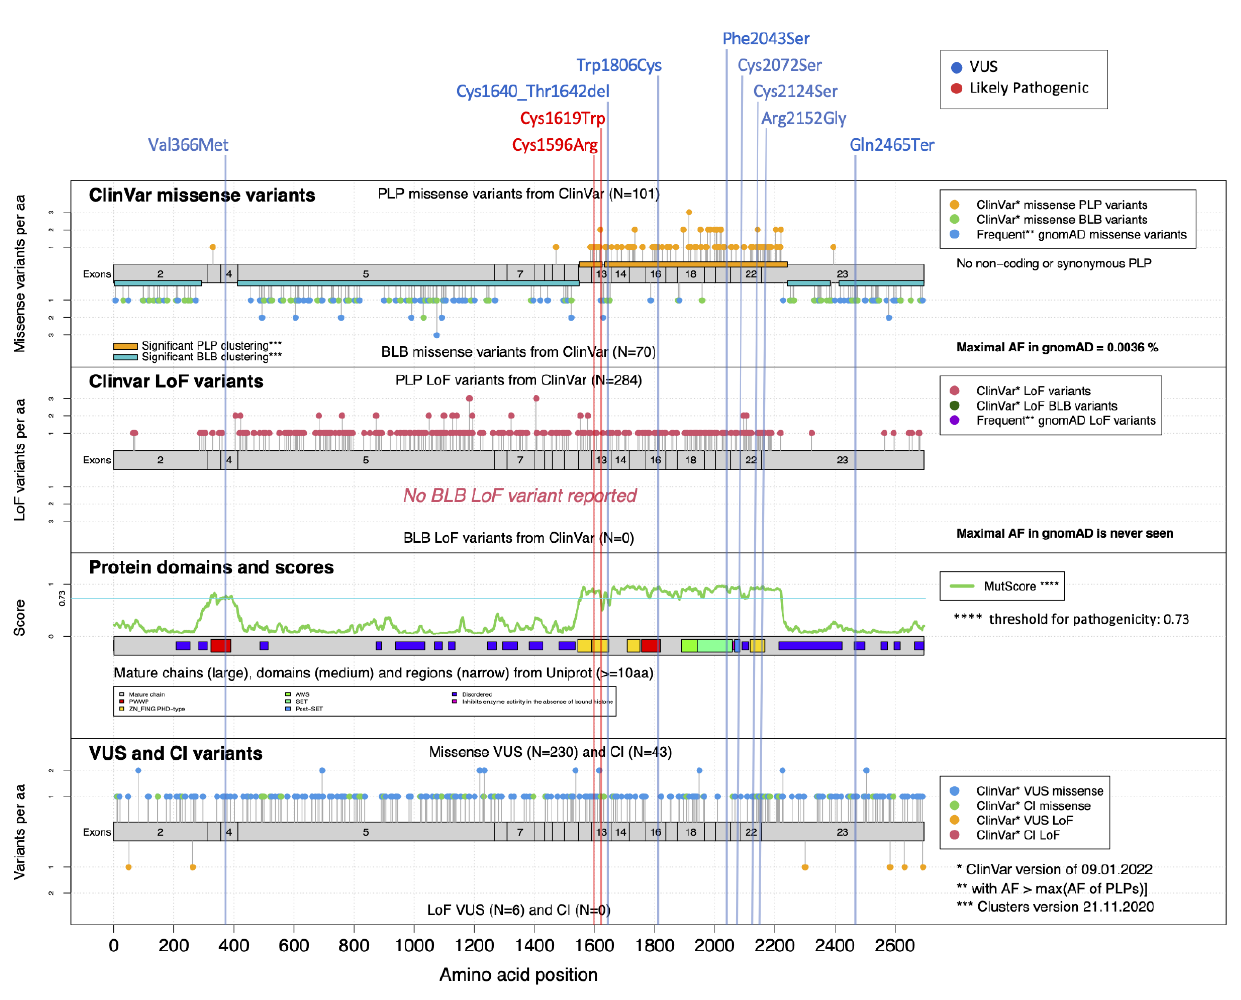
Figure 2. Mutational landscape for NSD1 . MutLand plot for NSD1 (NM_022455.4) [9], showing exons, functional domains and variants reported in ClinVar. Location of the variants included in the present study are also shown, as per different ACMG classification (blue, VoUS; red, likely pathogenic). Positions of the missense and LoF NSD1 variants reported in ClinVar known to be either pathogenic/likely pathogenic (PLP) or benign/likely benign (BLB) are shown (top diagrams), whereas VoUS or variants having conflicting interpretation (CI) reported by ClinVar, either missense or LoF, are shown in the bottom diagram. The cartoons highlight the regions for which MutScore detects significant PLP clustering (orange horizontal bars). A diagram reporting the functional domains of the protein (PHD, yellow; PWWP, red; SET, light green), and plotting the MutScore referred for the entire protein sequence is also shown (third plot from the top).